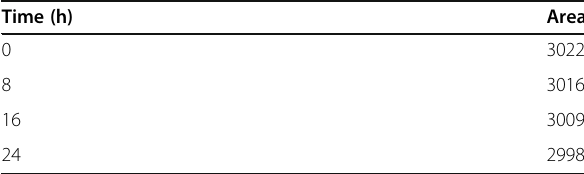
Table 6 Result of solution stability